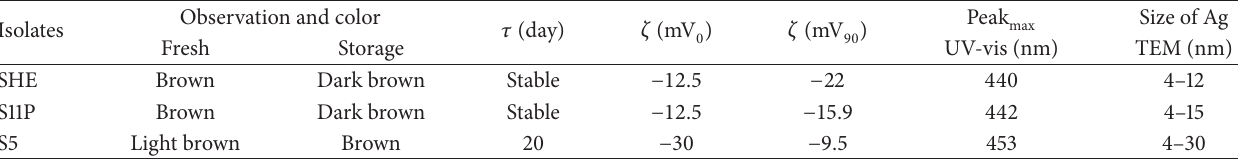
Table 1: Characteristics and stability ( 𝜁 in millivolts) of the produced nanosilver particles after 90 days of production for the three selected